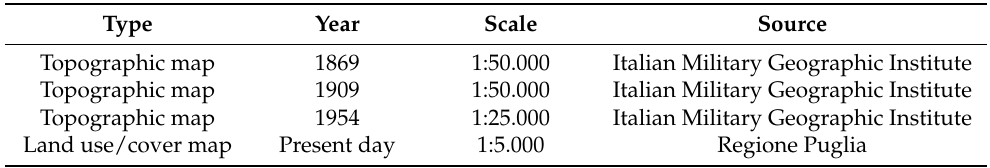
Table 1. Cartographic products used for the definition of land use categories in the study area from 1869 to the present day.